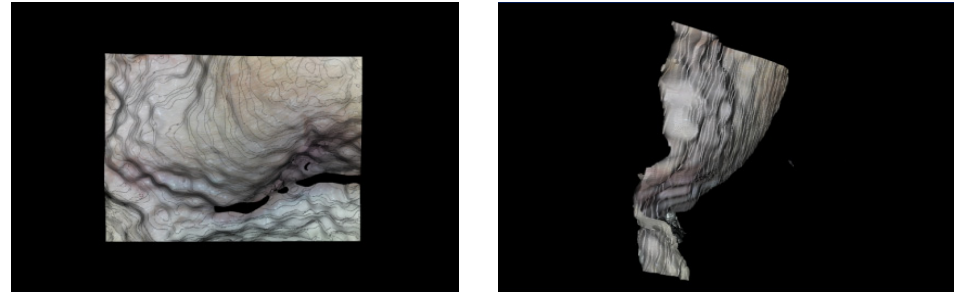
Figure 9. Result of textured surface acquisition for an in vitro porcine stomach.